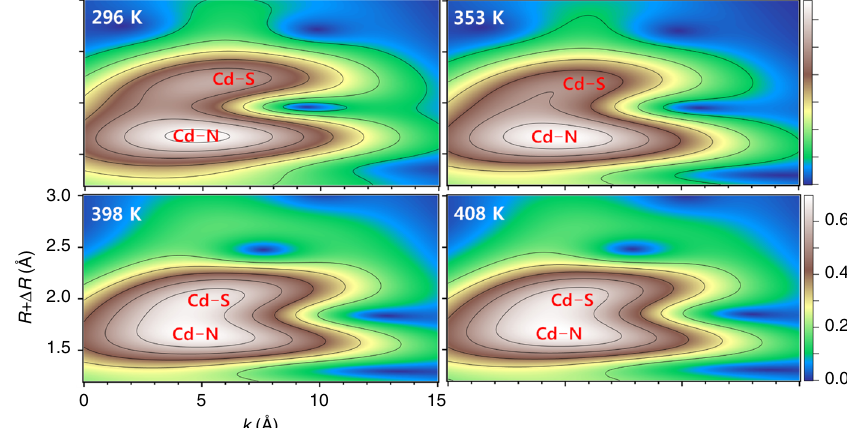
Fig. 7 Wavelet transform EXAFS of CP 1 at different temperatures. The heights of the peaks are represented by different